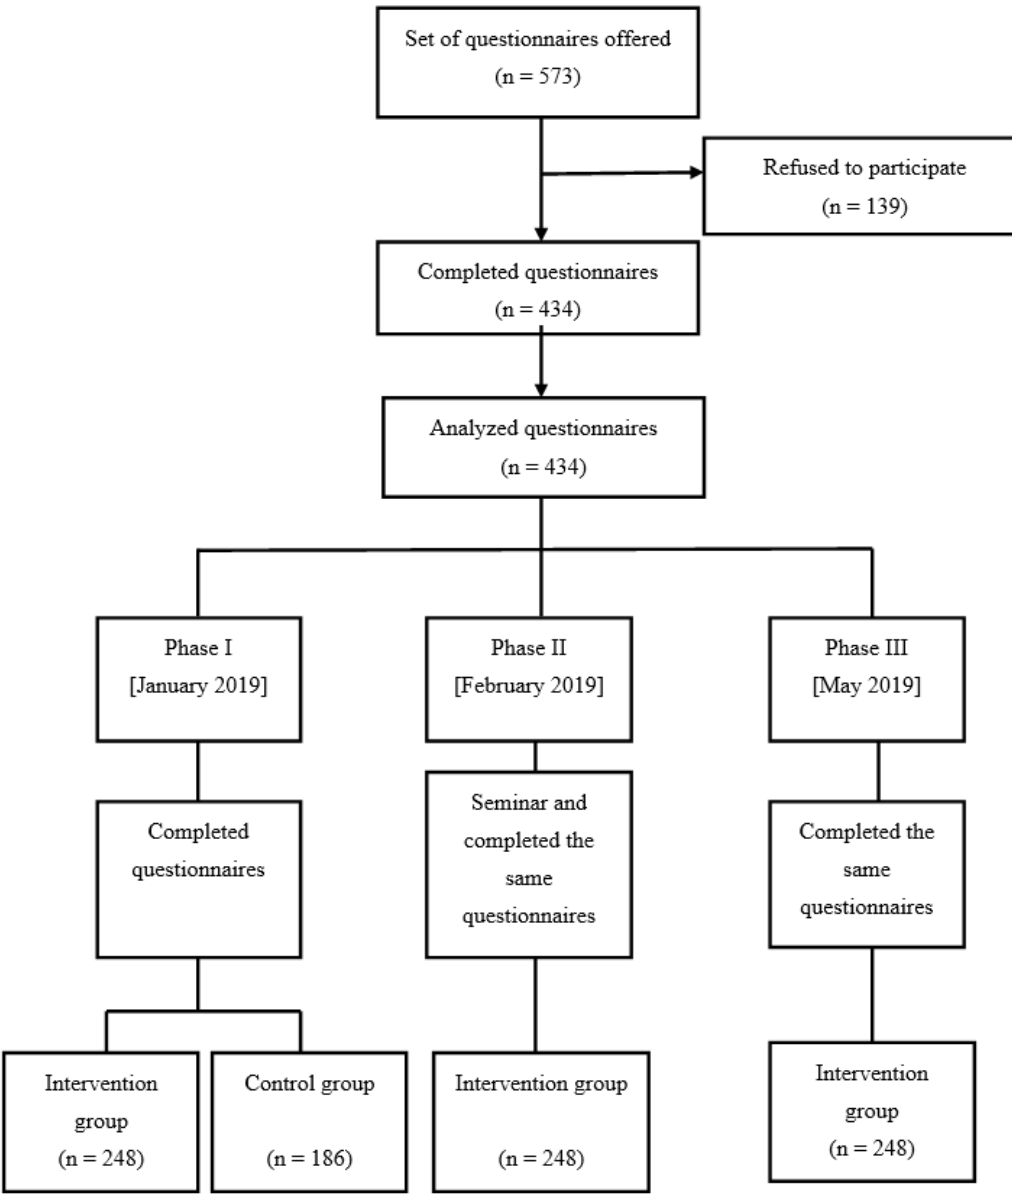
Figure 1. The flow diagram of the study.